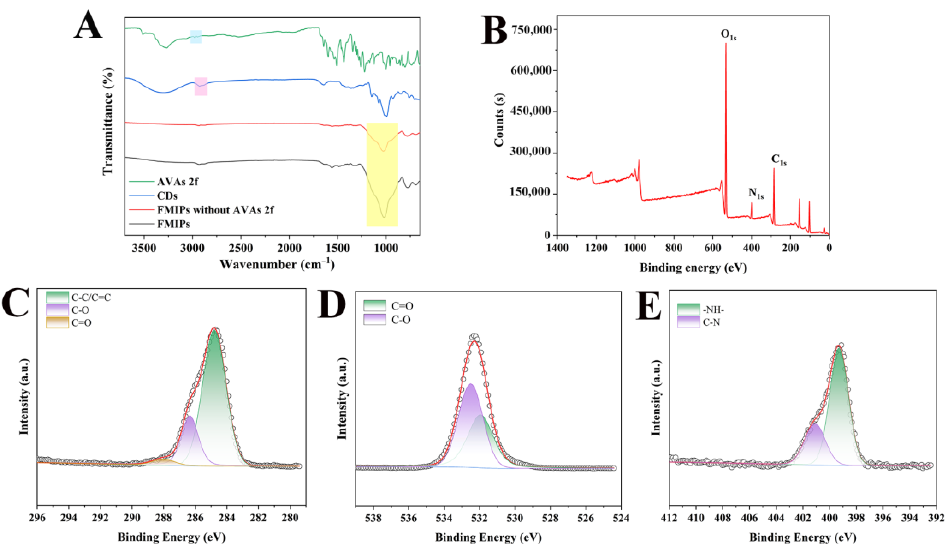
Figure 2. ( A ) FT − IR spectrum of FMIPs, FMIPs without AVAs 2f, CDs, and AVAs 2f. ( B ) XPS spectrum of FMIPs. High-resolution XPS peaks of FMIPs: ( C ) C 1s , ( D ) O 1s , and ( E ) N 1s .